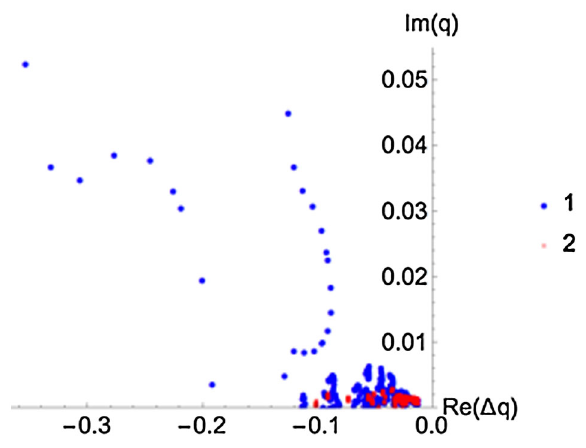
FIG. 32. Tune shifts of unstable modes for the full 25 ns LHC beam at chromaticity ξ ¼ 18 , ImpF ¼ 2 , damper off (blue, 1), and with resistive gain g ¼ 1 . 4 (red, 2). Both with and without damper, there are no unstable modes with positive tune shifts. Seventeen representative coupled-bunch mode numbers are depicted.